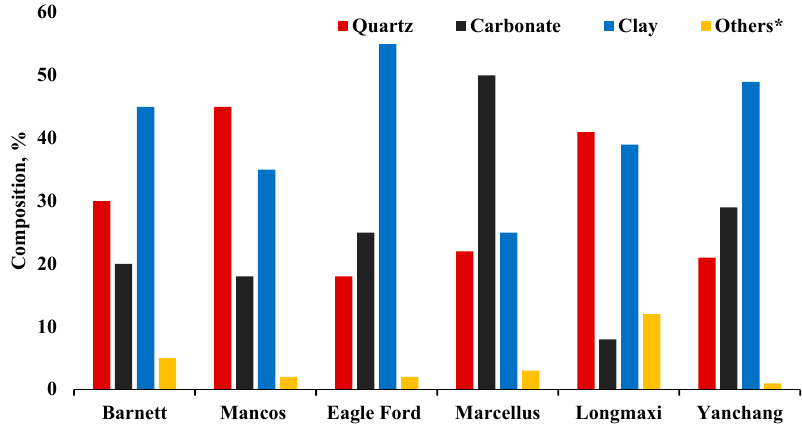
Figure 3. Typical mineral compositions of some shale formations .